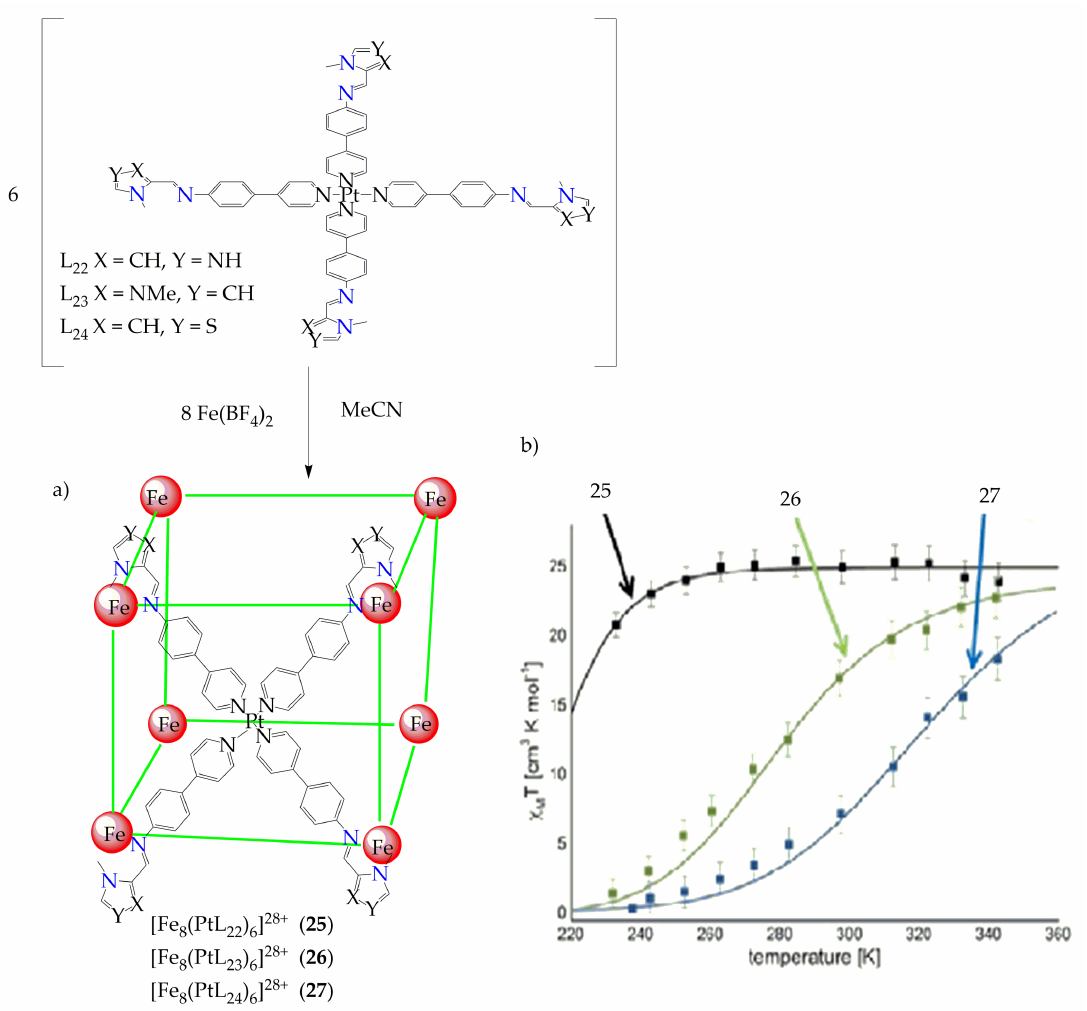
Figure 17. ( a ) Hetero-bimetallic cubic architecture of ( a ) [Fe II 8 (PtL 22–24 ) 6 ](BF 4 ) 28 and ( b ) plots of χ M T vs. T for cubic cages of [Fe II 8 (PtL 22–24 ) 6 ](BF 4 ) 28 . Reproduced with permission from [104]; Published by Wiley